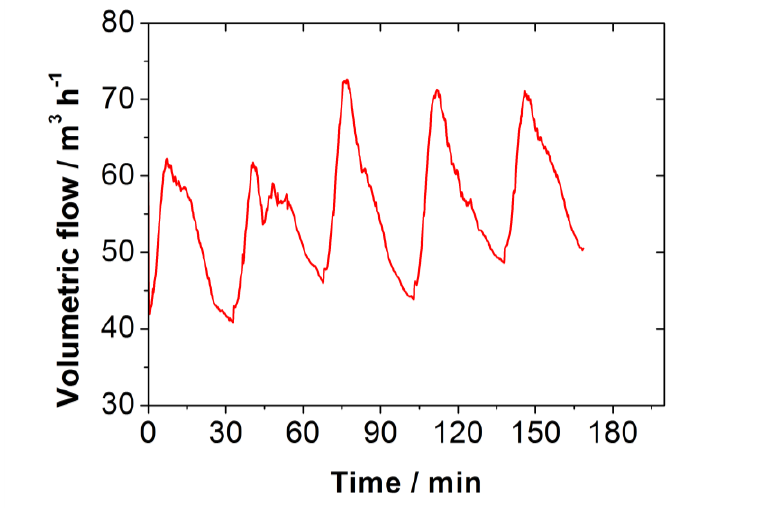
Figure 4. Volumetric flow through the firing system and accordingly through the catalyst in the wood log